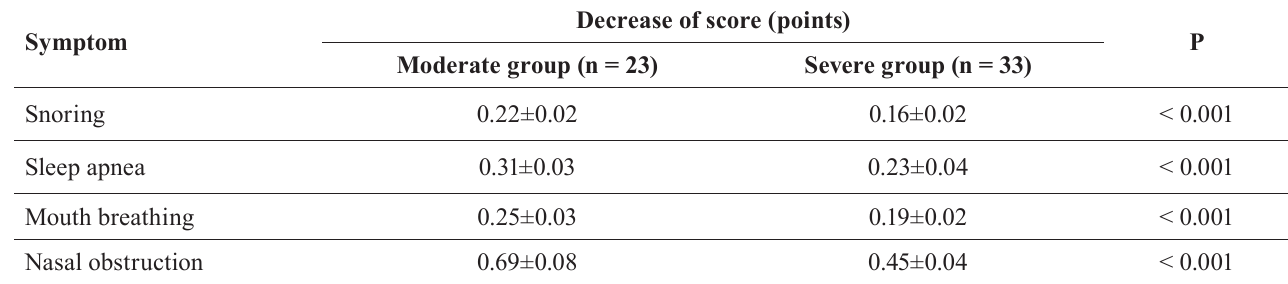
TABLEIII - Decrease of symptom scores after treatment in two groups